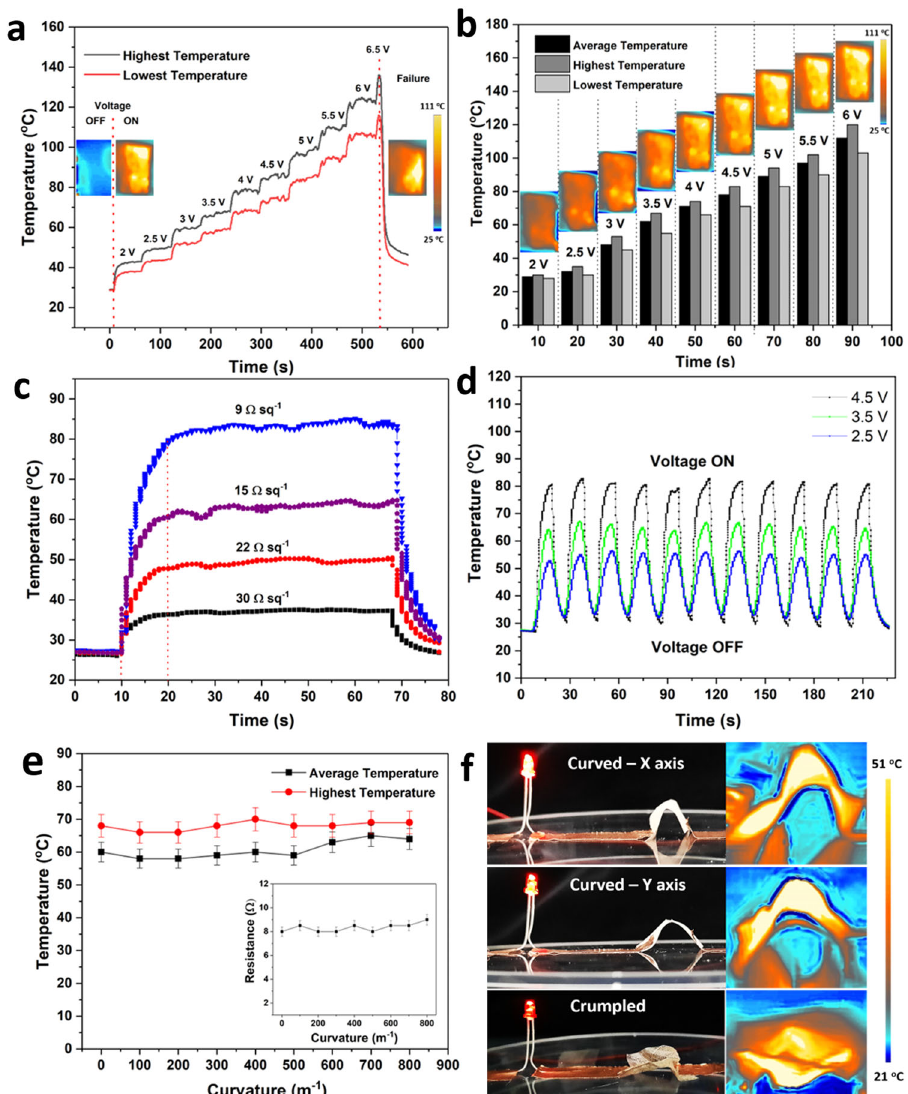
Fig. 3 Heating characteristics of the bioinspired electrode. a Transient temperature evolution of the bioinspired heater electrode at stepwise voltage rises from 2 to 6.5 V for Ag nanowire loading of 200 μ g cm − 2 . b Highest, lowest, and the average temperatures along with their corresponding infrared camera images. c Time-dependent surface temperatures with different sheet resistances at 4.5 V. d Temperature response over heating cycles at different voltages. e Change in temperature when the bioinspired heater electrode is bent. Inset shows the change in corresponding resistance values upon bending and the error bars show the standard deviations calculated from three independent measurements. f Digital photographs and their corresponding infrared camera images of the bioinspired heater electrode used as a conductor in the circuit when bent in the X axis, Y axis, and in crumpled positions. The Ag nanowire loading is 200 μ g cm − 2 and the bias applied is 3